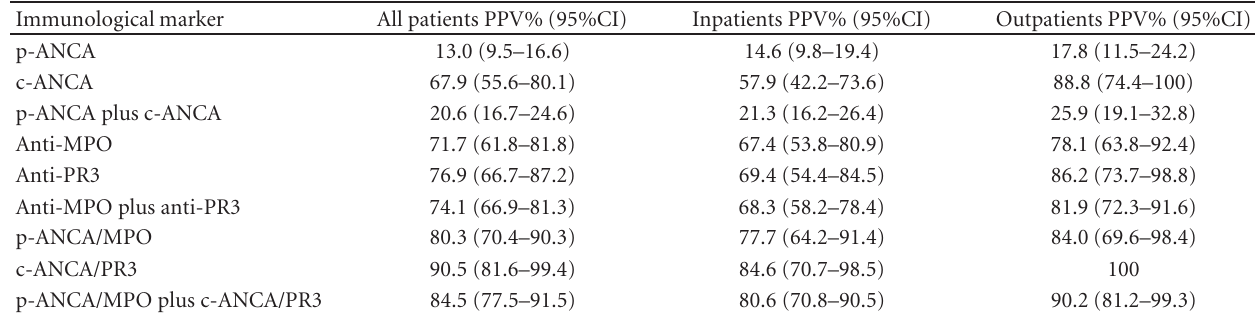
Table 4: Positive predictive values (PPV) of ANCA testing for